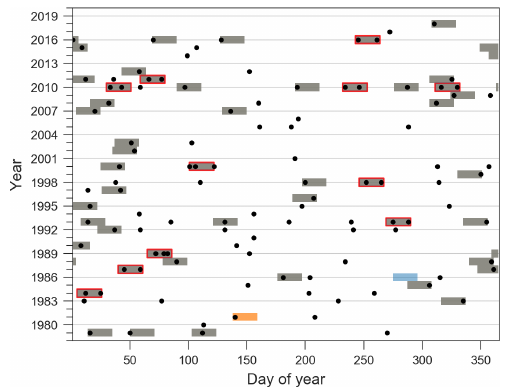
Figure A2. Catchment 5060089390 located in Australia, with rare clustering ( S cl = 26 . 79) and a high degree of similarity between the classifications Cl n and Cl acc : S cont = 0 . 9. In that case, most of the contribution to precipitation accumulations is due to isolated ex- treme events. A total of 11 episodes contain two or more extreme events ( n w > = 2). Extreme events and episodes are shown as in Fig. A1.